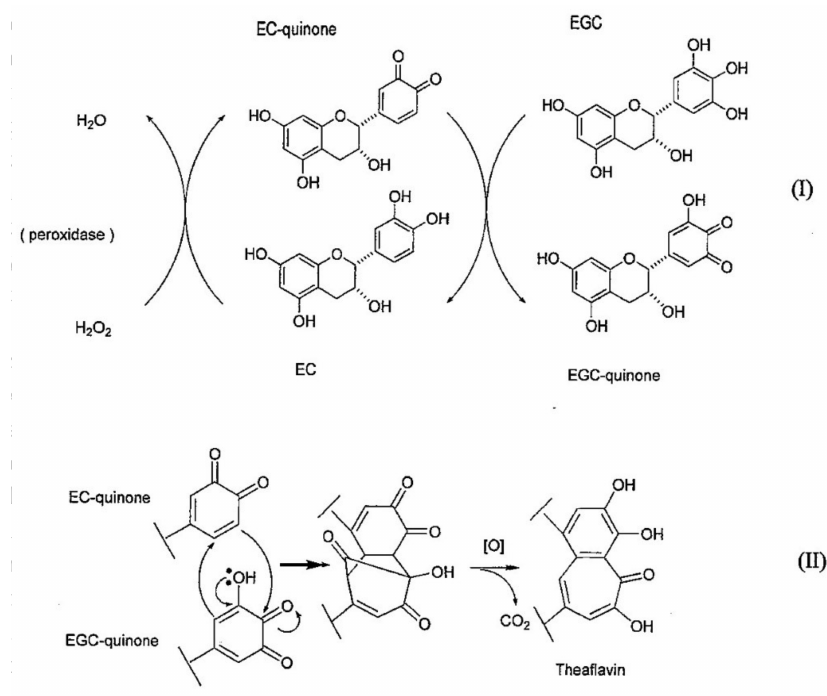
Figure 3. The biosynthetic pathway of